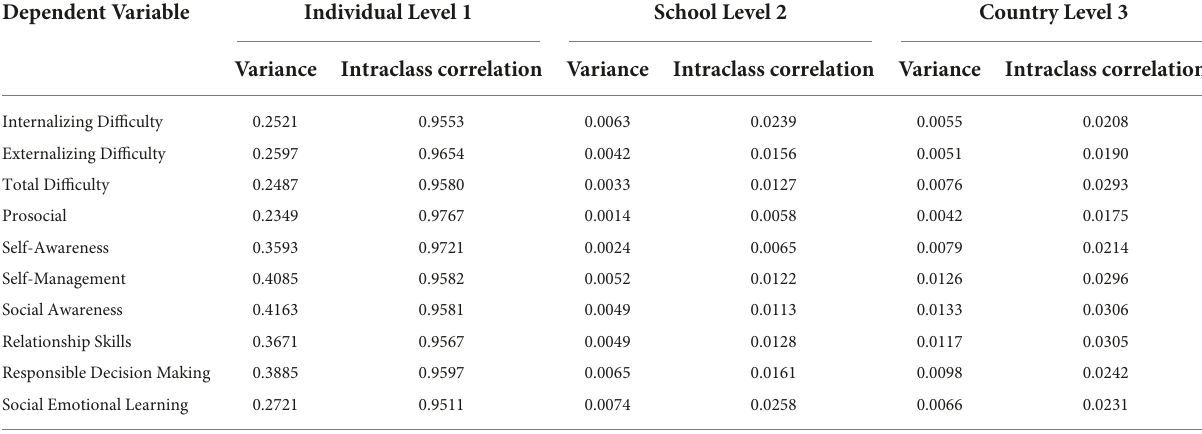
TABLE 10 Variances and Intraclass correlations at levels 1, 2 and 3 (Parent